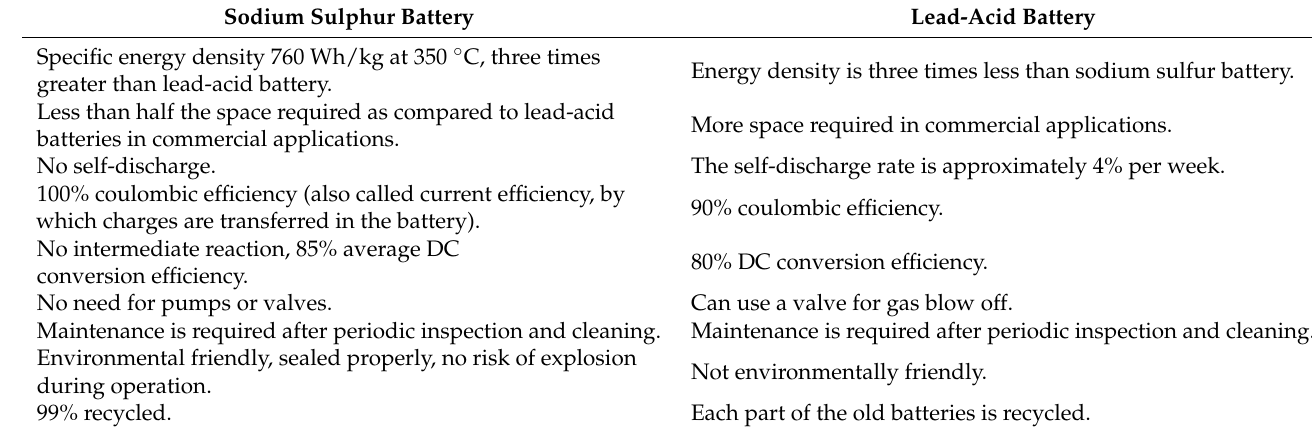
Table 3. Comparison between NaS and Li-acid